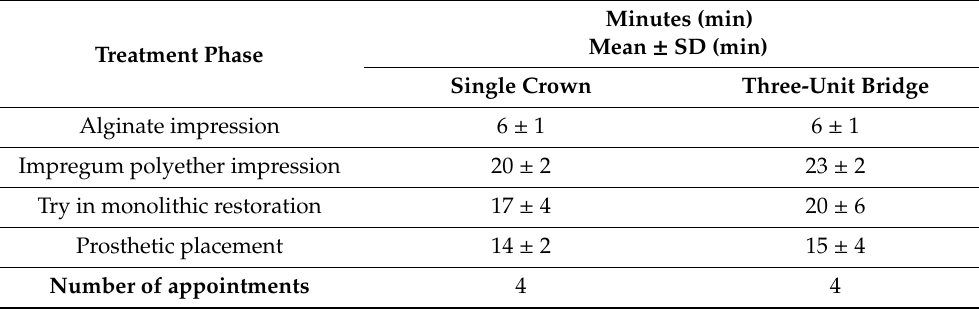
Table 3. Time e ffi ciency (conventional protocol).